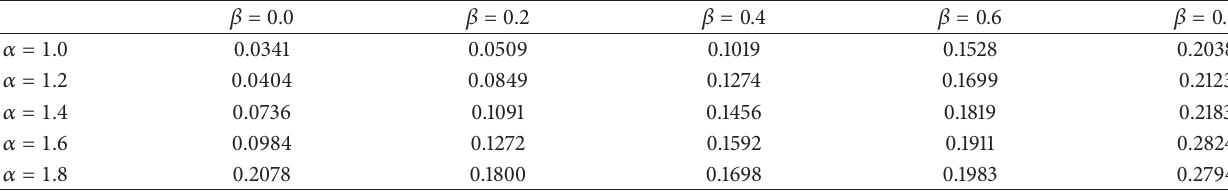
− 𝜇 ∗ ) for left-skewed disturbance. oep,lft oep,nml